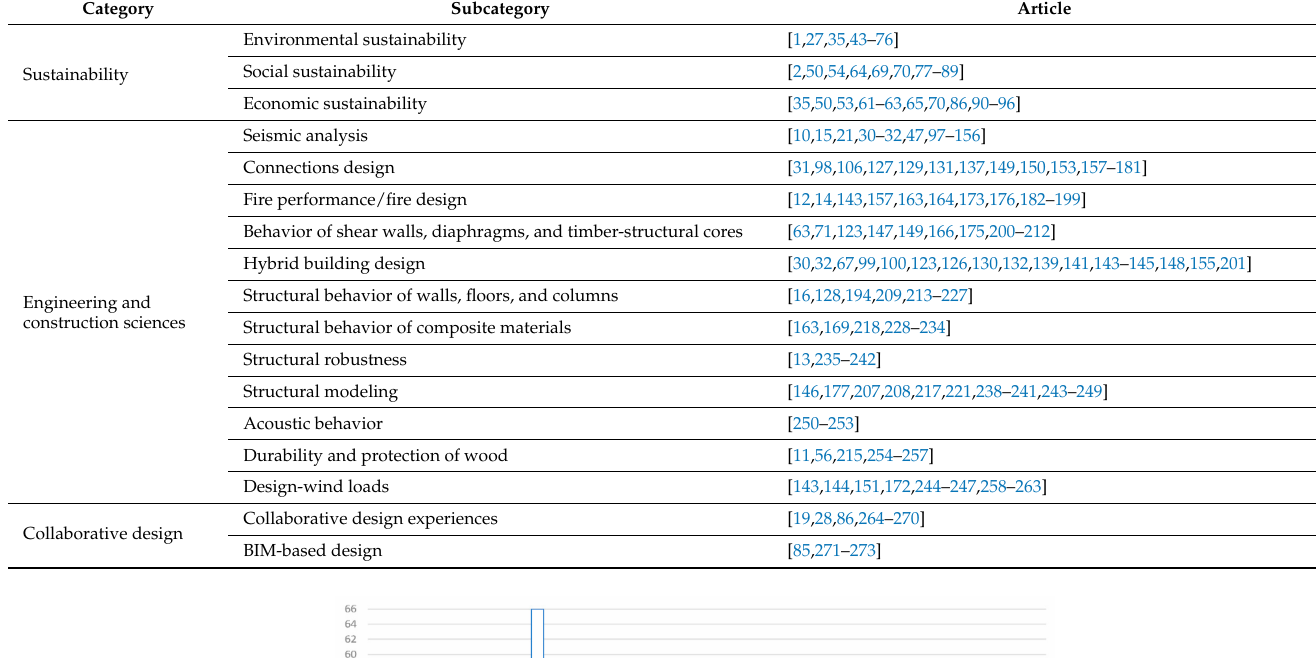
Table 1. Scientific articles on multi-storey timber buildings by subcategories.